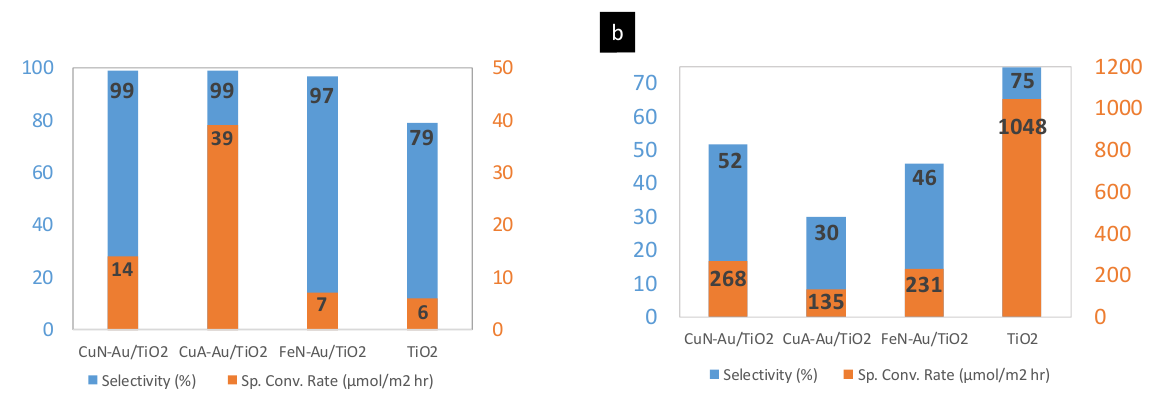
Figure 2. Photocatalytic activity of sol – gel-synthesized bimetallic TiO 2 in the batch system ( a ) and microflow system ( b ) after 60 min of the photocatalytic experiment with 1 mM BnOH under UV light.